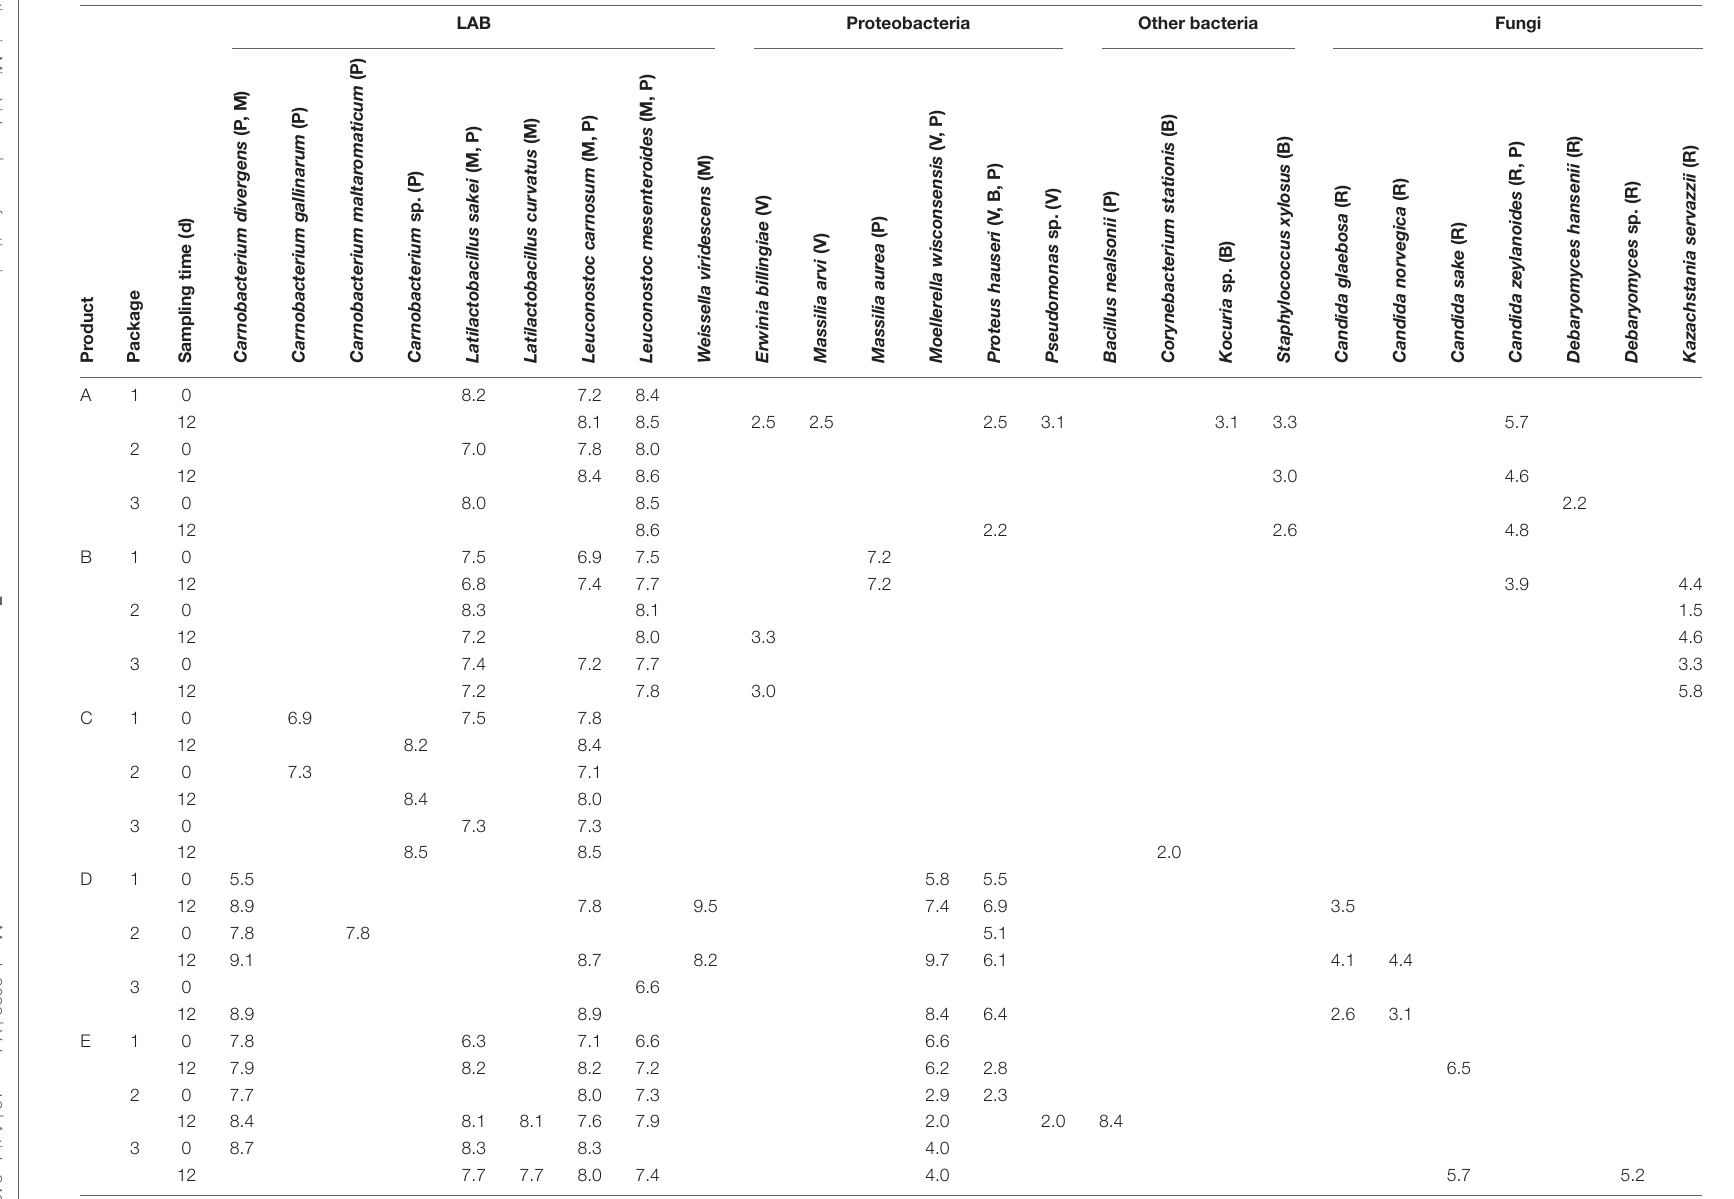
TABLE 1 | Dominant microbial contaminants isolated from PCA (P), MRSA (M), VRBGA (V), RBCA (R), and BPA (B) plates at 0 and 12 days of secondary shelf